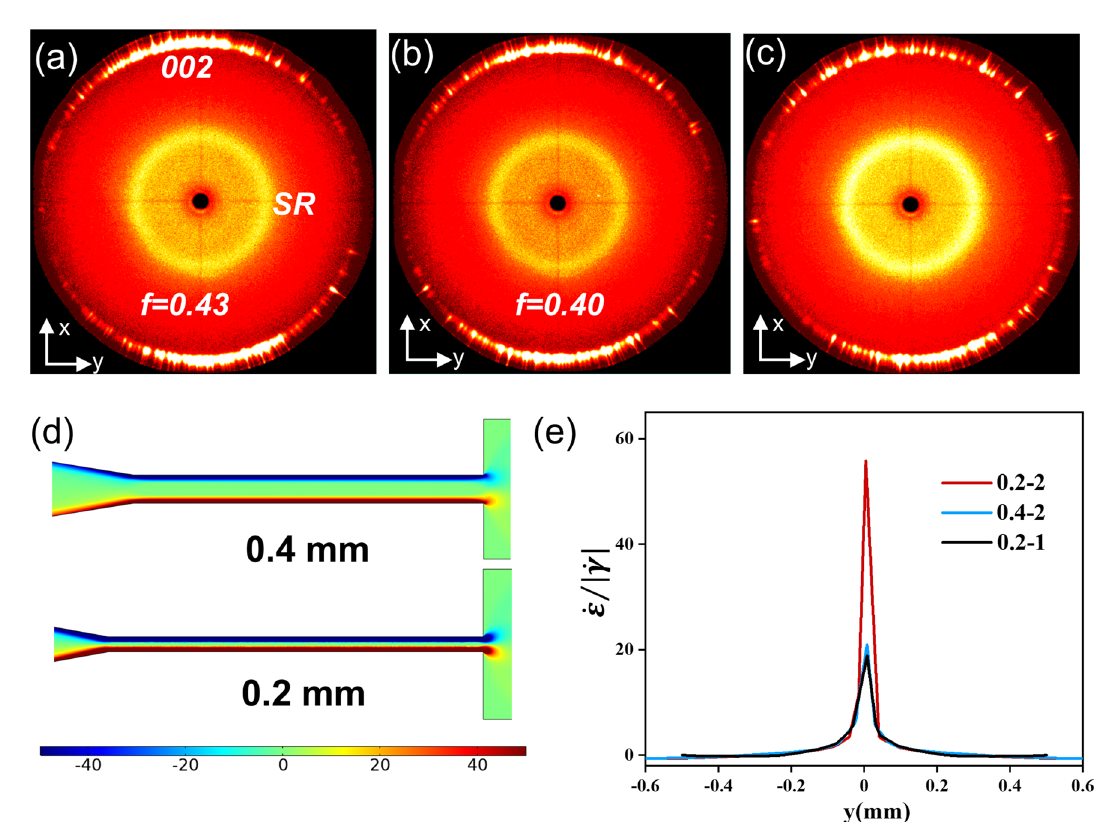
Fig. 5 Orientation analysis and comparison of expansion molds with different shapes. 2D WAXS patterns from the x – y plane of 60 V-BN/SG strip fabricated by expansion molds, a 0.2–2, b 0.4–2, c 0.2–1. d Calculated shear rate distribution along the longitudinal narrow channel with 0.2 and 0.4 mm height. e Comparison of the rate ratio at x = 10.5 mm of these molds as a function of the location y in the wide